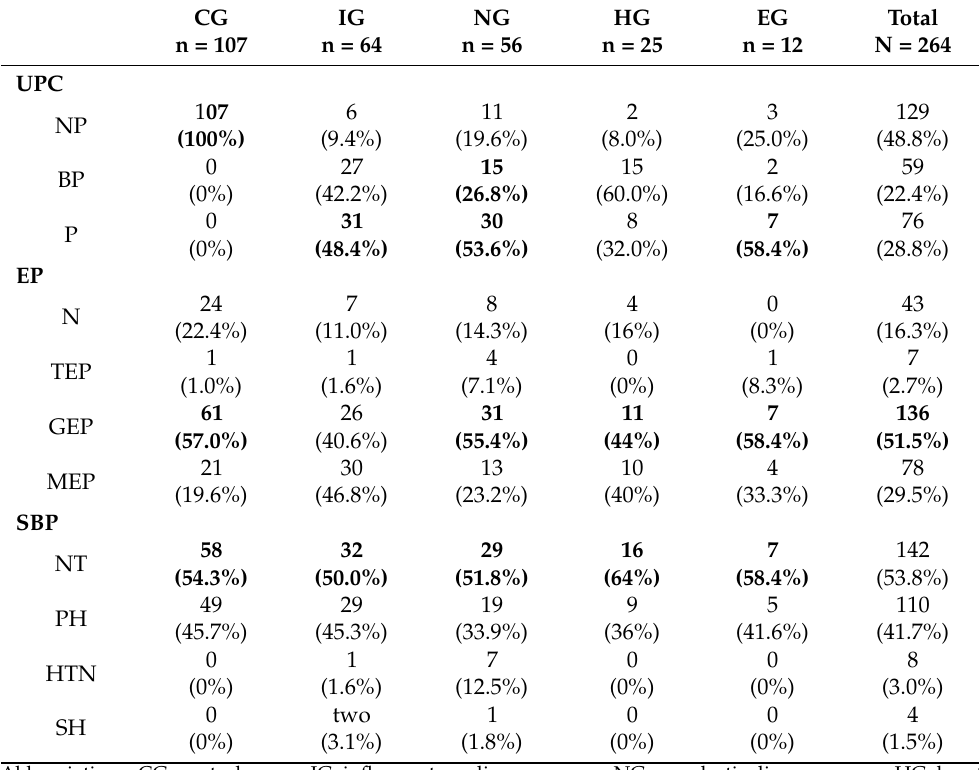
Table 3. Distribution of frequencies and percentages of UPC, electrophoretic pattern, and SBP in the groups studied.